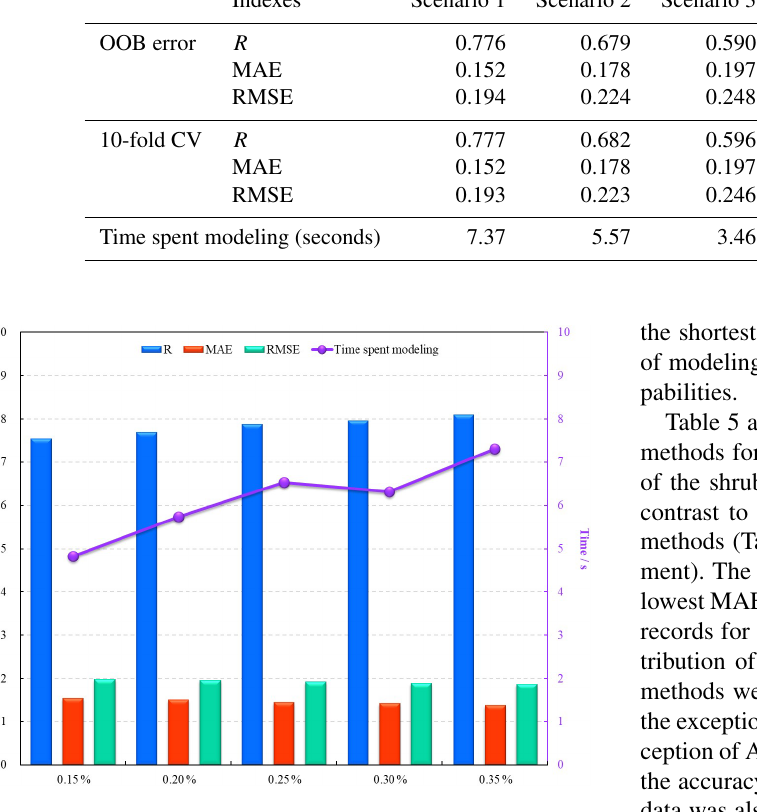
Figure 4. The performance of random forest models when increas- ing the size of the training sample for shrub